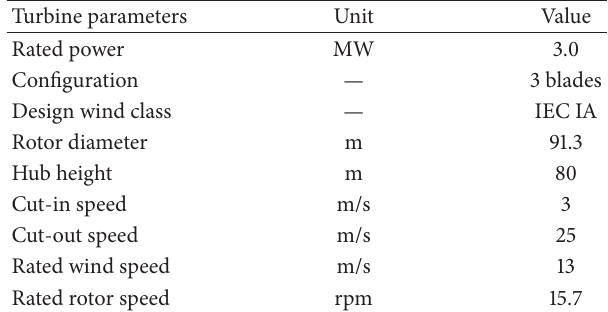
Table 1: Details of 3.0 MW wind turbine